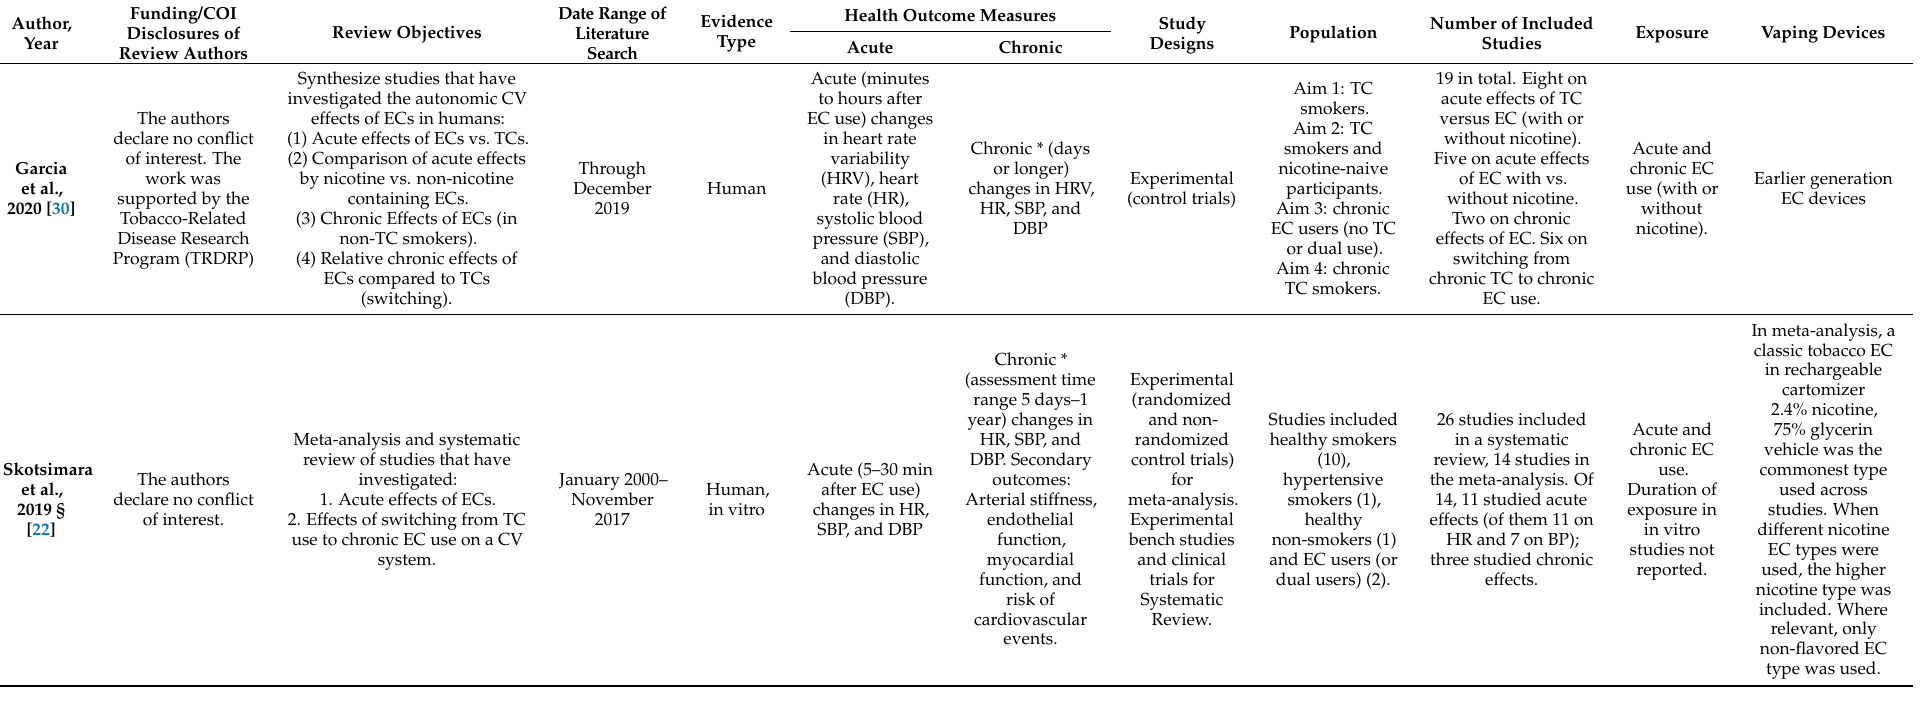
Table 1. Characteristics of systematic reviews on the cardiovascular health risks of